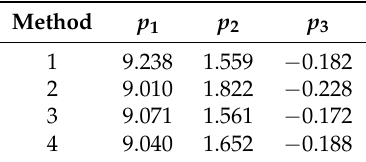
Table 4. Optimum dependency coefficients (6) for criteria 1–4 for average values of 25 mm pipes.